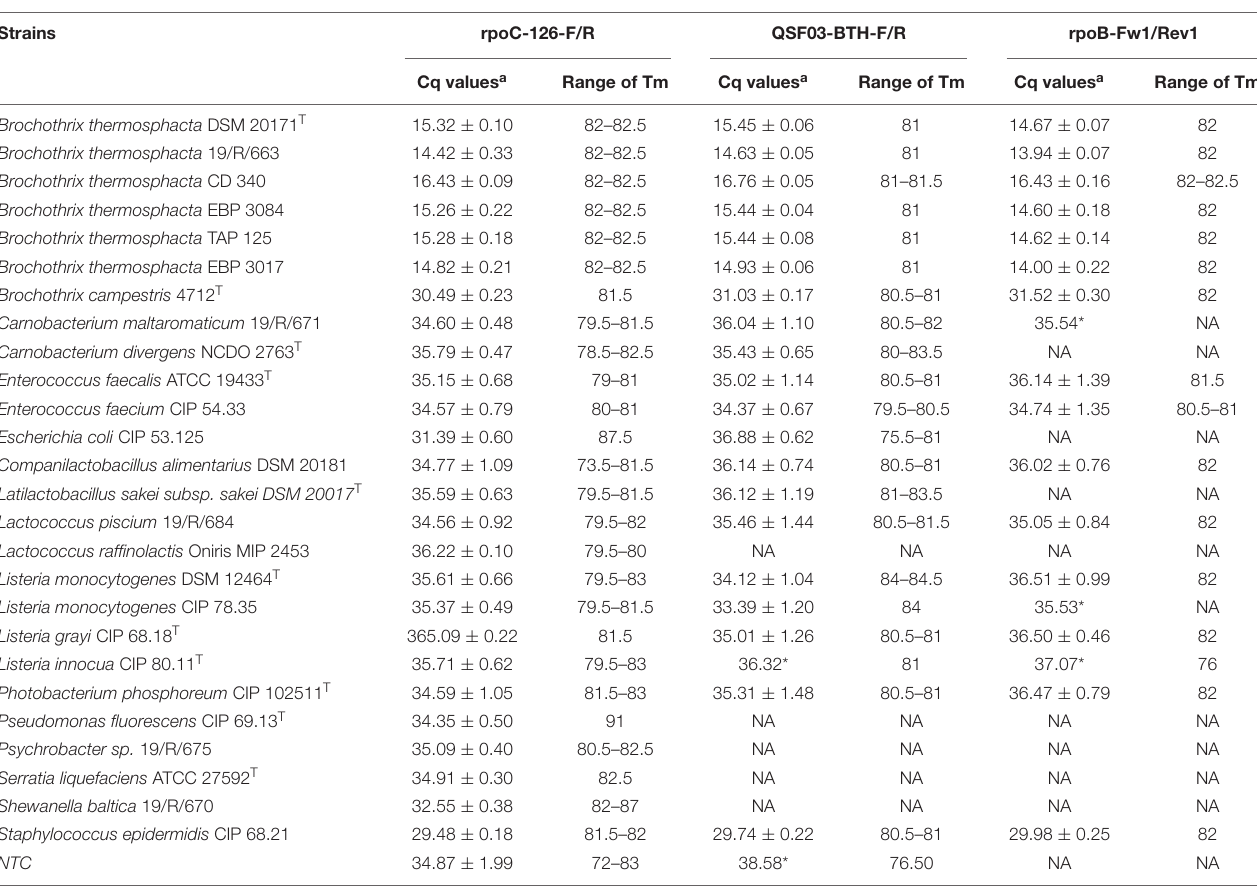
TABLE 3 | Primer specificity (Cq